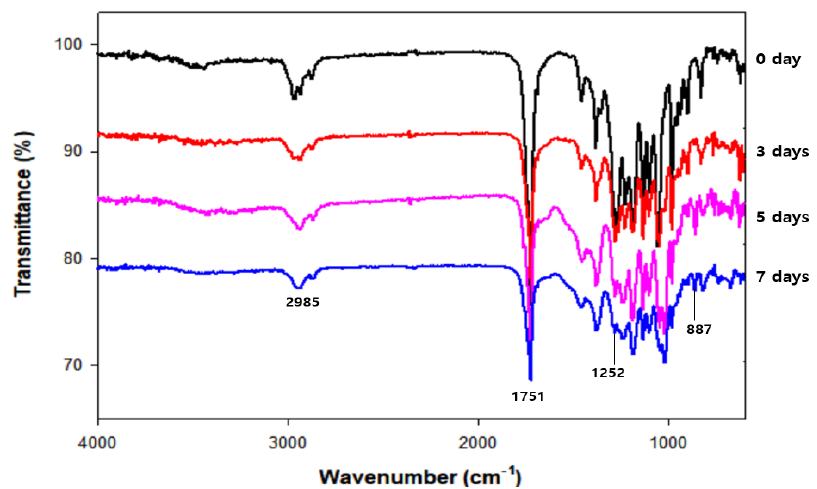
Figure 4. Change of physical properties of degraded poly(3-hydroxybutyrate) (PHB) analyzed by Fourier transform infrared spectroscopy (FT-IR) to observe some changes in functional groups after degradation.